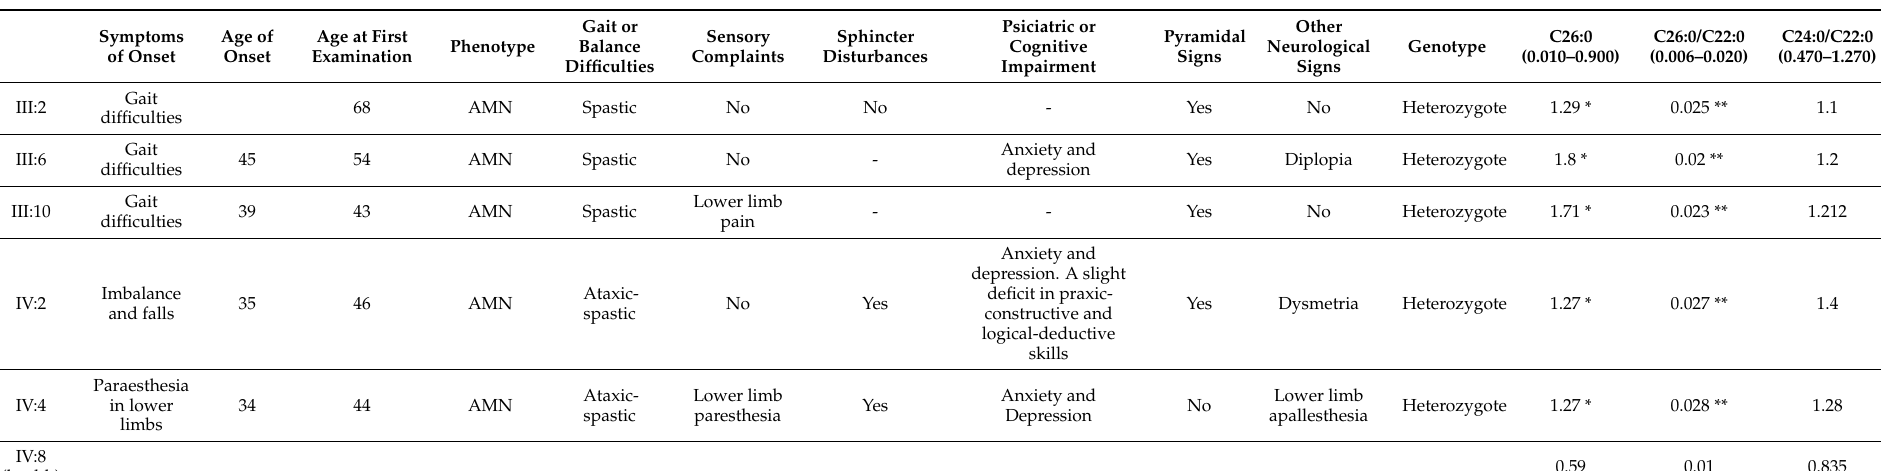
Table 1. Clinical and biochemical features of the five symptomatic female carriers of the p.Arg554His (III:2; III:6; III:10; IV:2 and IV:4) and one healthy male. VLFA dosage was conducted in plasma. C26:0 levels, C24:0/C22:0 and C26:0/C22:0 ratios were increased in all the female samples (C26:0 levels * p = 0.0078; C26:0/C22:0 ** p =